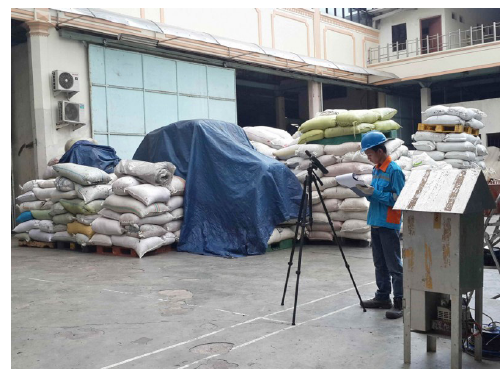
Figure 5. An example of proper noise measurement conducted by Badan Pengelola Lingkungan Hidup Daerah DKI Jakarta in dealing with community complaints due to air and sound pollution of Elastis Reka Aktif Company in